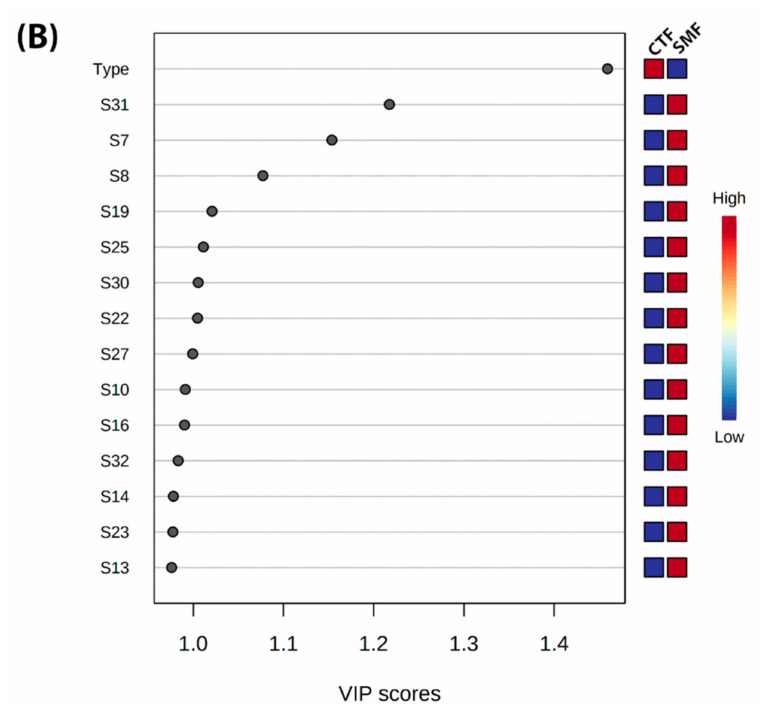
Figure 6. ( A ) Partial least squares discriminant analysis (PLS-DA) score plot in 2D graphs using the concentrations of all VOCs grouped by dairy breed. ( B ) Variable Importance in Projection (VIP) plots derived from the e-nose signals for the VOCs by two types of F-MC manufactured with milk from different dairy breeds (Holstein vs. Jersey).